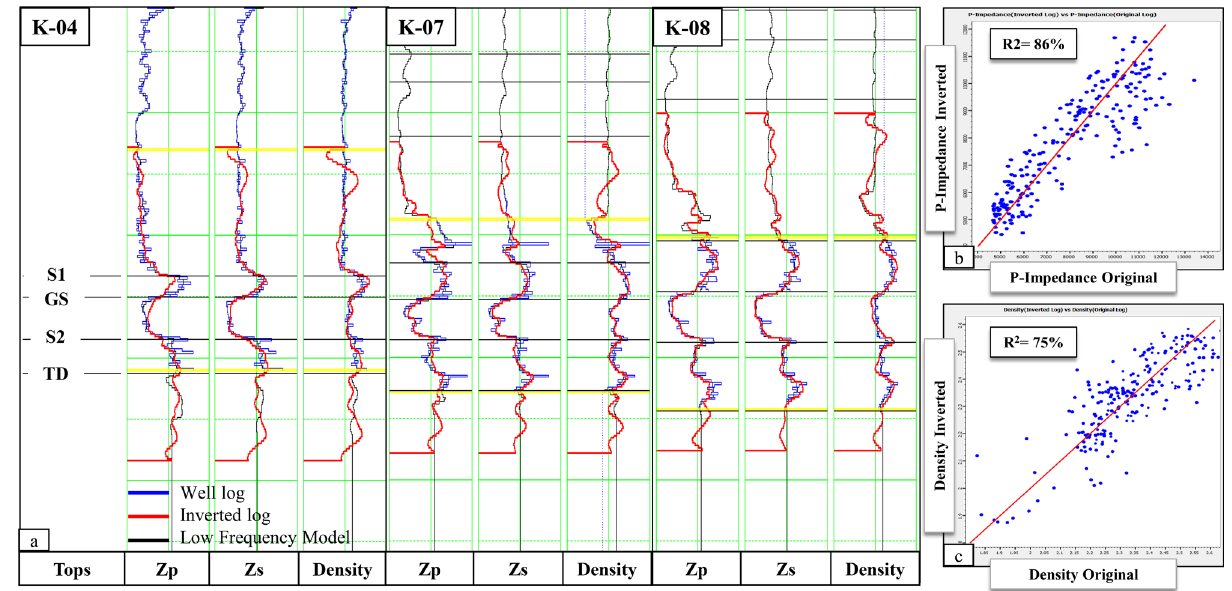
Fig. 14 a Pre-stack inverted elastic logs p -impedance (Zp), s- imped- ance (Zs) and density comparisons at three well locations: actual (in blue) versus inverted (in red) along with low-frequency log (in black),